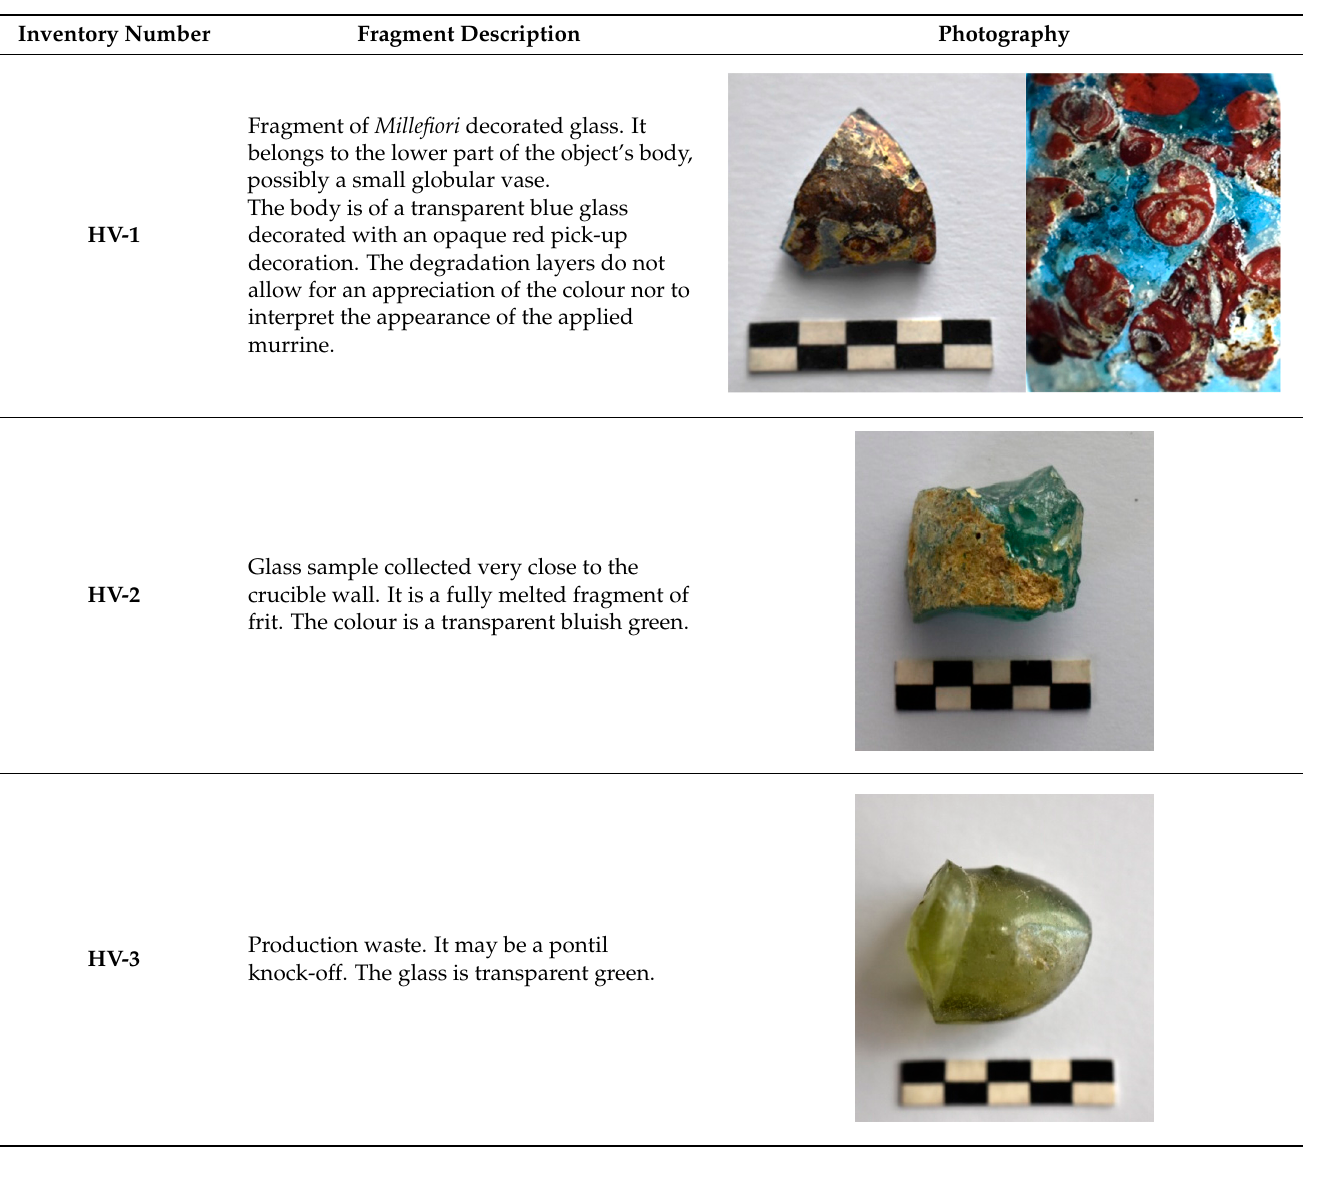
Figure 1. Example of the glass remains found during the excavation at Calle del Horno del Vidrio in Granada, Spain. Table 1. Description of the fragments under study and the respective photography.